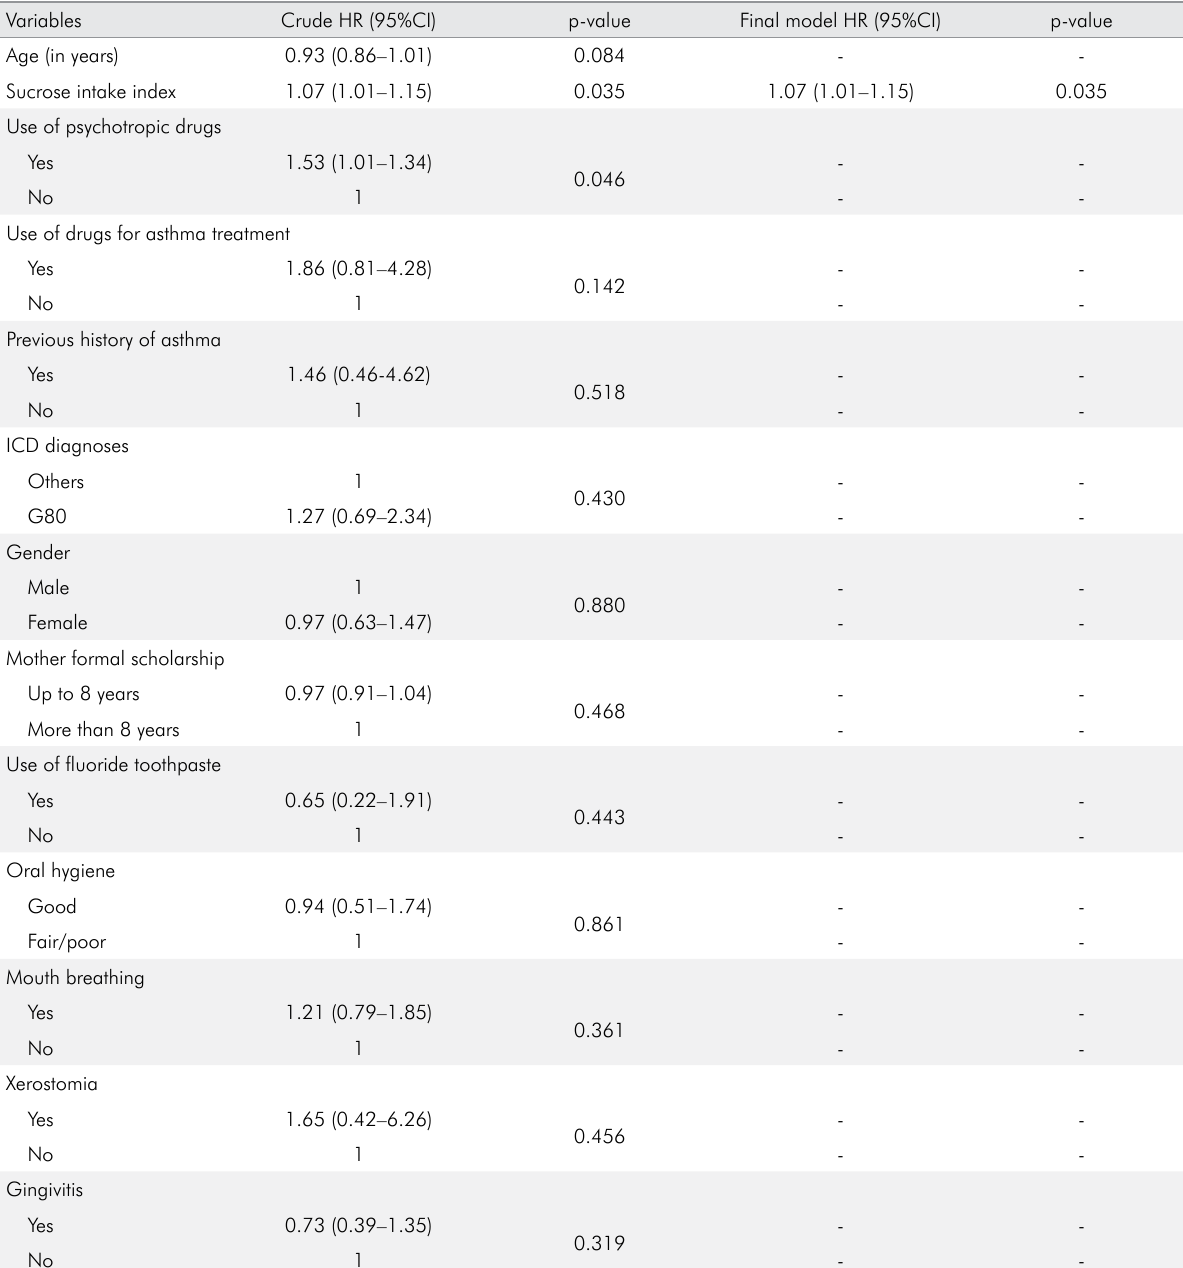
Table 2. Risk factors for dental caries among patients with developmental disabilities, Belo Horizonte, Brazil, 1998 to 2014.